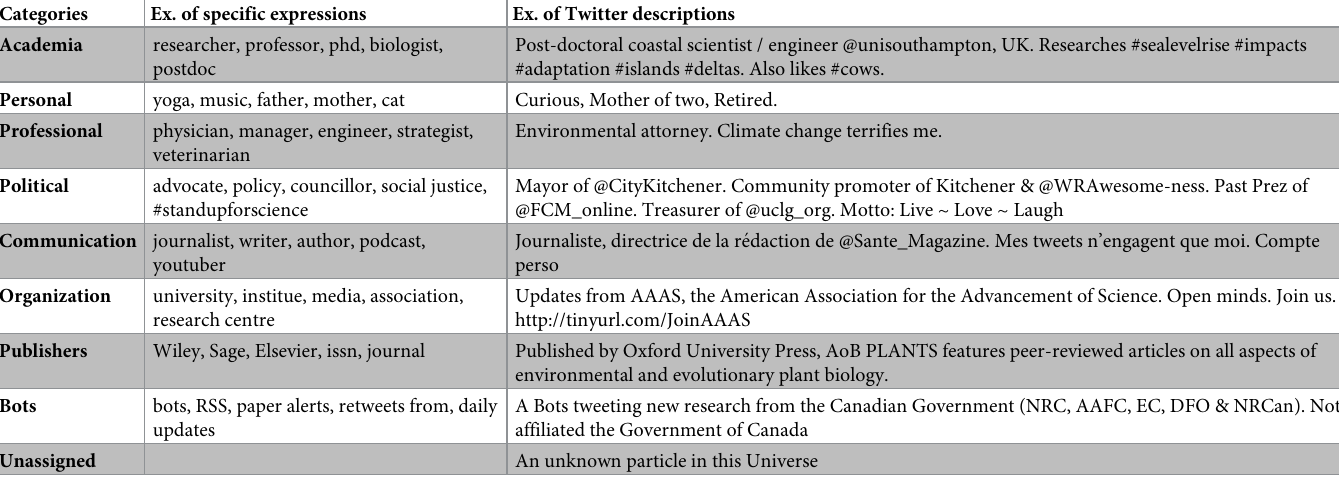
Table 1. Categories and matching expressions used for textual analysis of Twitter